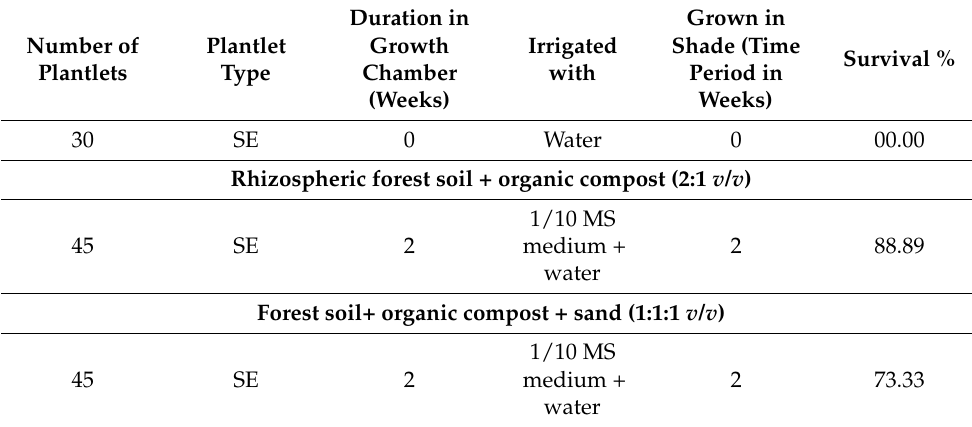
Table 5. Acclimatization of in vitro-raised plantlets of V. canescens